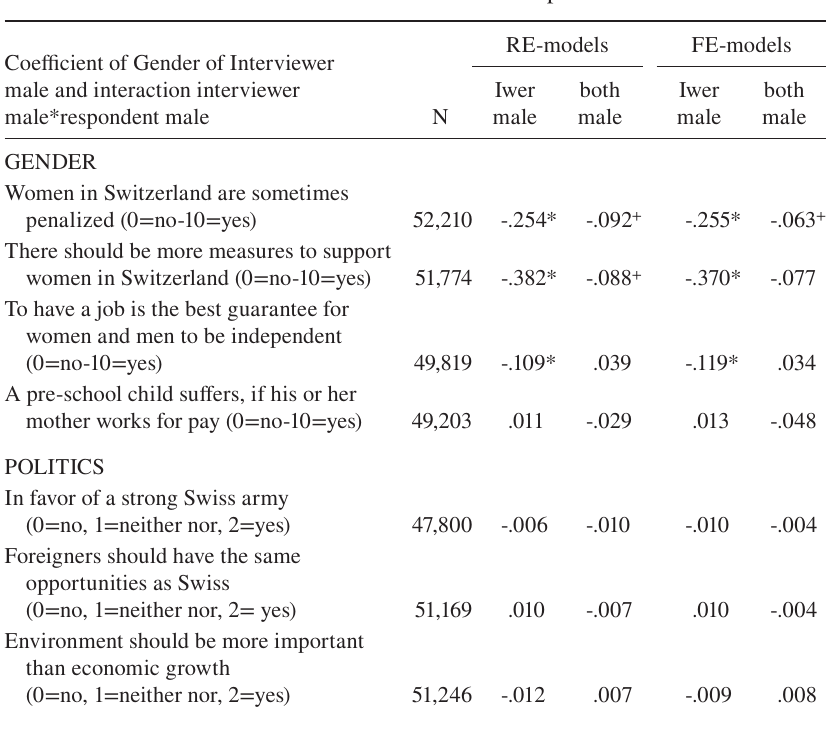
Random and fixed linear effects model coefficients of